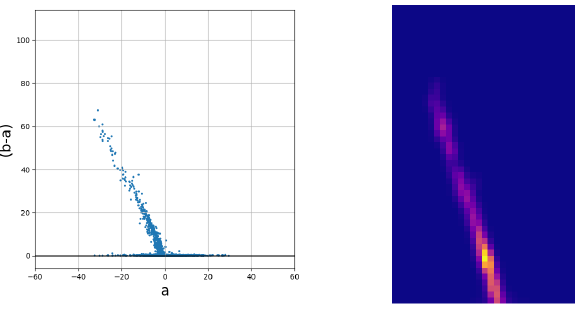
Figure A5. Tense driver with SAV seat.